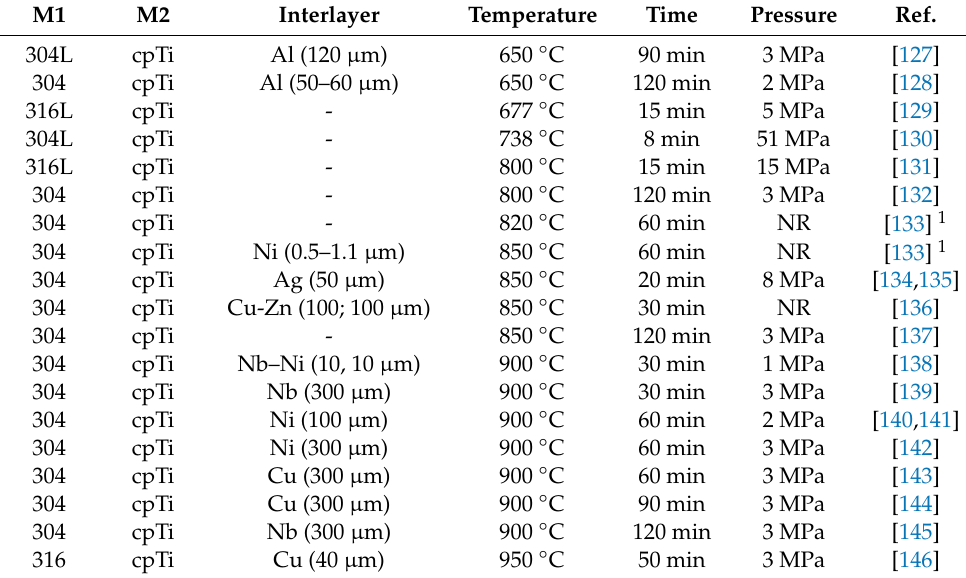
Table 4. Reported parameters for di ff usion bonding and TLP bonding of 304 and 316 to commercially pure titanium